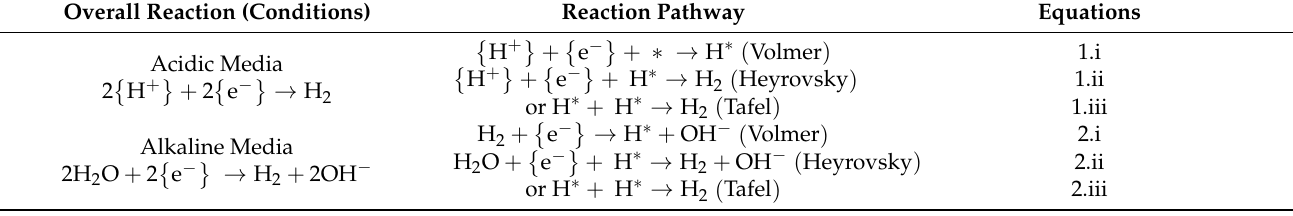
Table 1. Overall reaction pathways for HER in acidic/alkaline mediums. Overall Reaction (Conditions) Reaction Pathway Equations